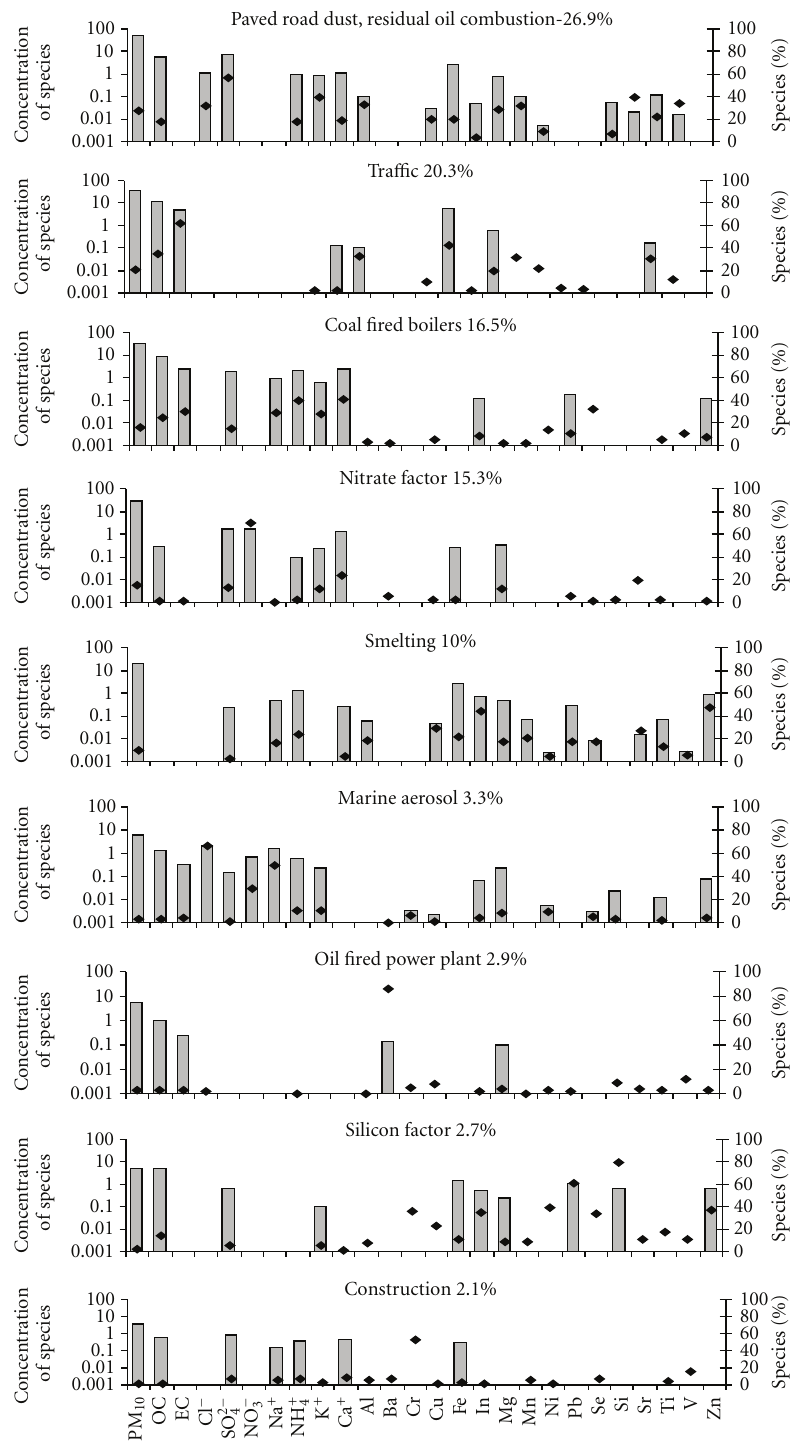
Figure 4: PMF factor Profile for